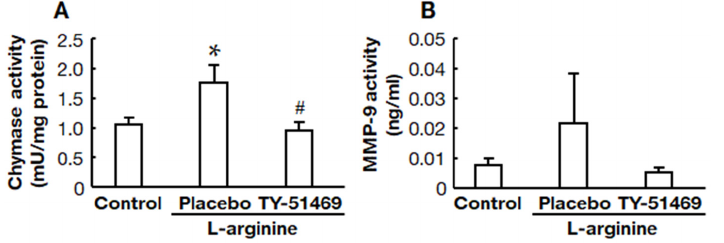
Figure 5. Effects of TY-51469 on chymase and MMP-9 activities in the pancreas. Pancreatic chymase ( A ) and MMP-9 ( B ) activities in the control, placebo-, and TY-51469-treated groups 8 h after the injection of L-arginine (control group: n = 6, placebo-treated group: n = 8, TY-51469-treated group: n = 8). Values represent means ± SEM. * p < 0.05 vs. control group. # p < 0.05 vs. placebo-treated group.